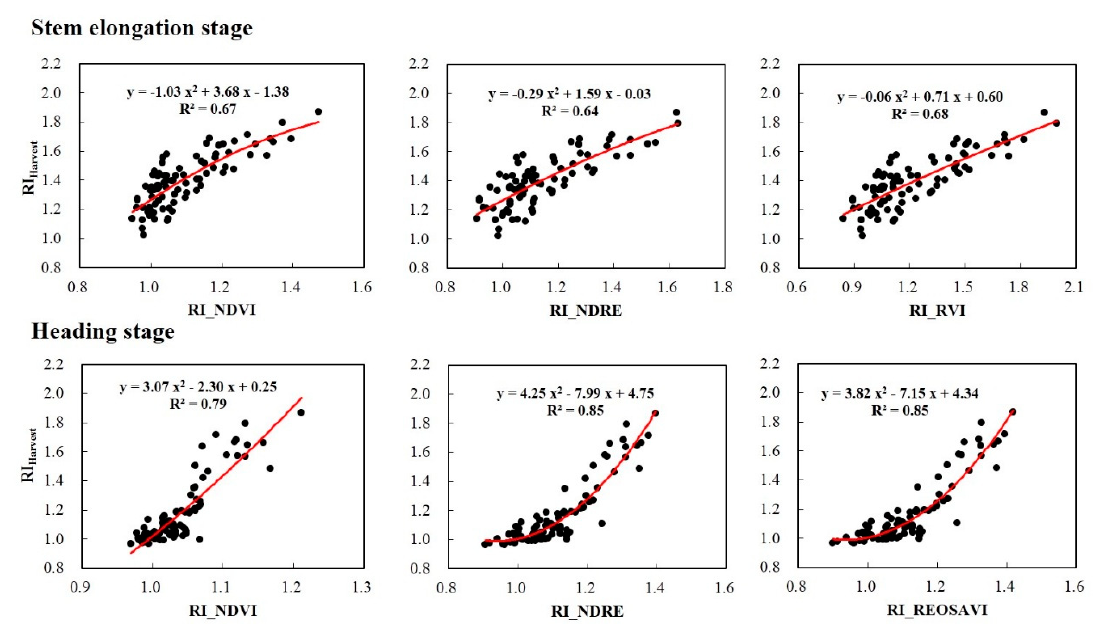
Figure 4. The relationships between response index calculated with yield (RI Harvest ) and response index calculated with NDVI, NDRE, RVI, and REOSAVI across all varieties at stem elongation stage and heading stage.